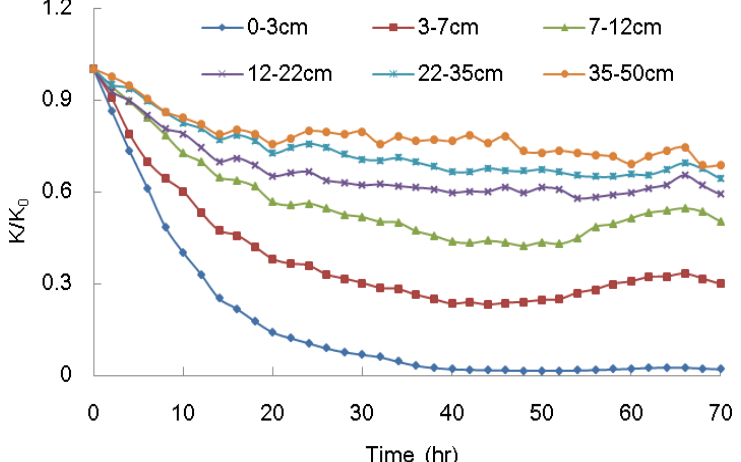
Figure 9. Different depths K vs. operation time (Exp. No.E7).